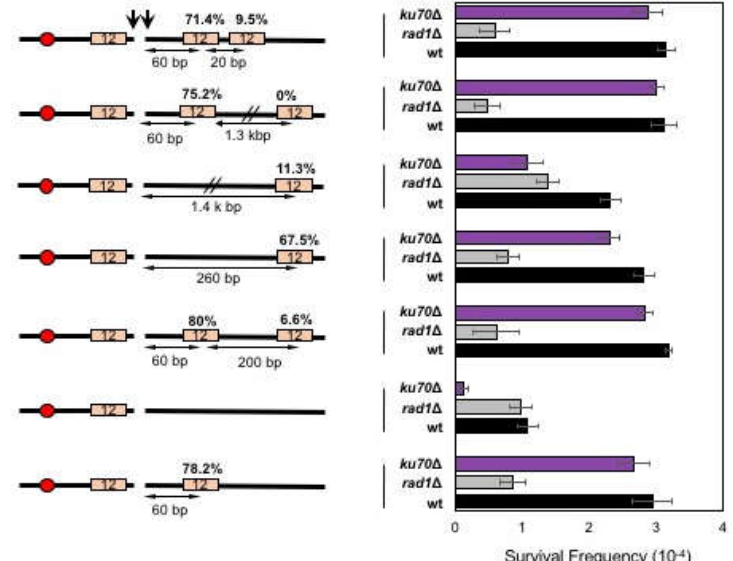
Figure 3. The effect of proximity on microhomology selection for MMEJ. ( Left ) A diagram of MMEJ reporters with microhomologies located at different distances to an HO break. The locations of HO cut site (arrow), microhomology (orange boxes), and centromere (red circles) are shown. The size of microhomology is shown in number (bp) inside the microhomology. The distance to the break (bp) is shown below each microhomology. Percentage of repair event was calculated by dividing the number of repair events using each microhomology with the number of all repair events, regardless of the repair types and shown above each microhomology. The repair events were analyzed by sequencing of the repair junctions from >100 Ura- survivors. ( Right ) Graph showing survival frequency ± SD in wild type (WT), RAD1 Δ (MMEJ deficient mutant), and ku70 Δ (C-NHEJ deficient mutant). Survival frequency was calculated as described in Figure 1. The results are the average of three independent